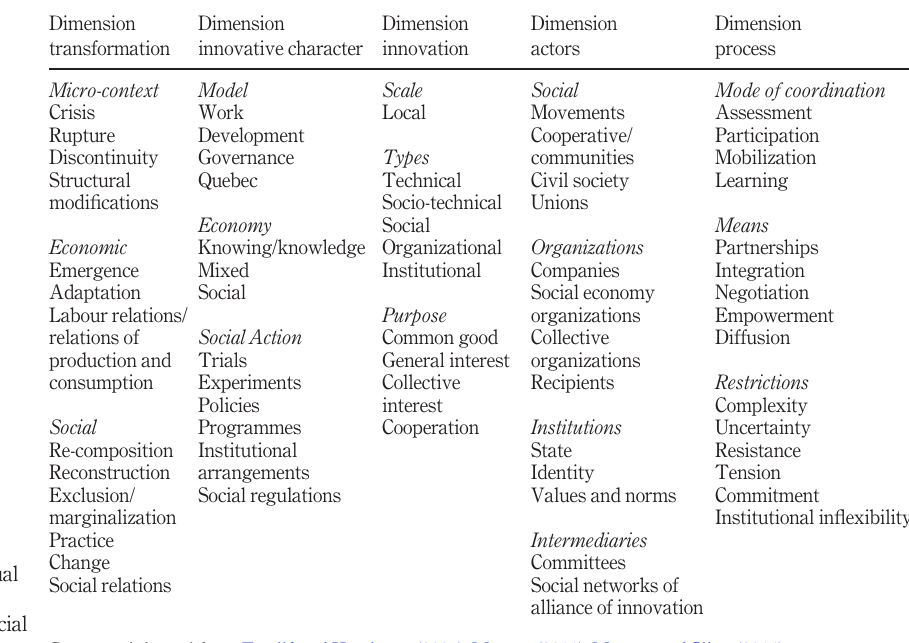
Table I. CRISES ’ conceptual encyclopaedia (dimensions of social